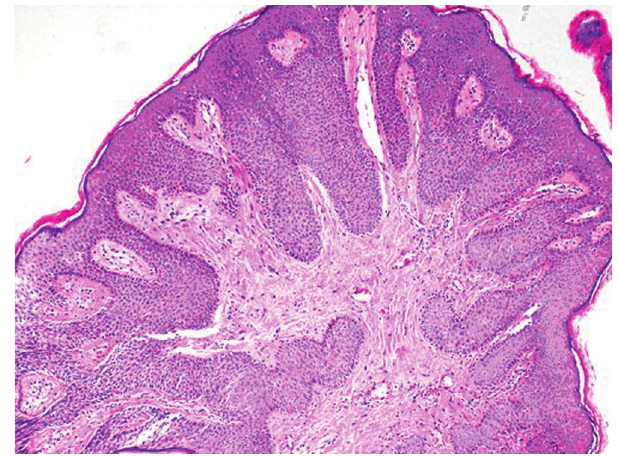
Figure 4 - Histological section under low power showing condyloma acuminata changes with prominent rete ridges and hyperkeratosis (H&E, 40